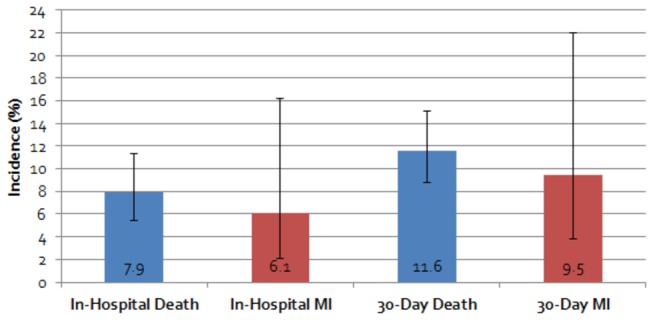
Pooled Incidence Rates and 95% Confidence Intervals for In-Hospital and 30-Day Mortality and Myocardial Infarction.